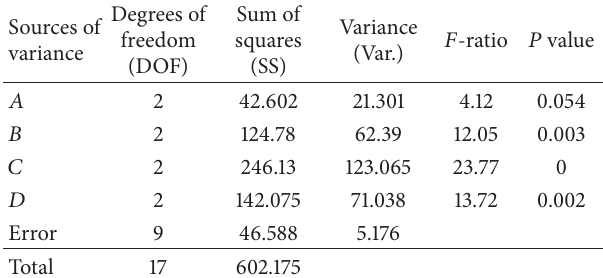
Table 6: ANOVA for cracking percentage.